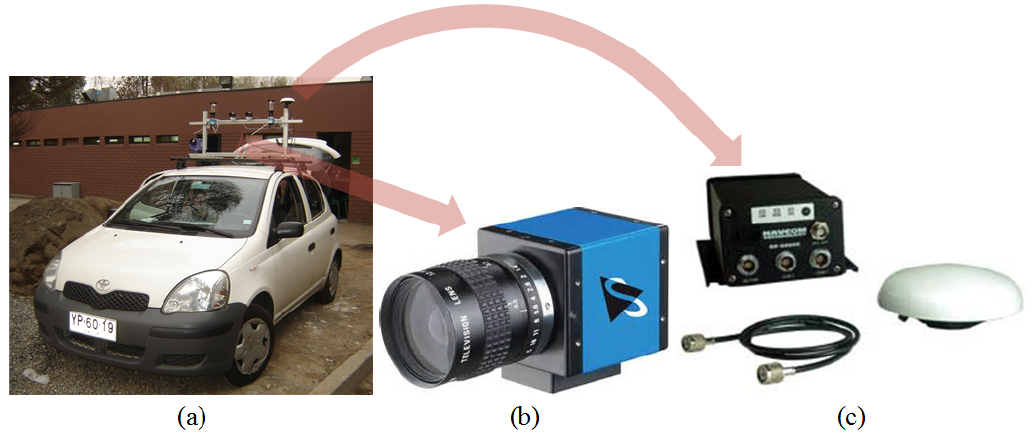
Figure 11. Experimental platform, vehicle ( a ); camera ( b ); and GPS ( c